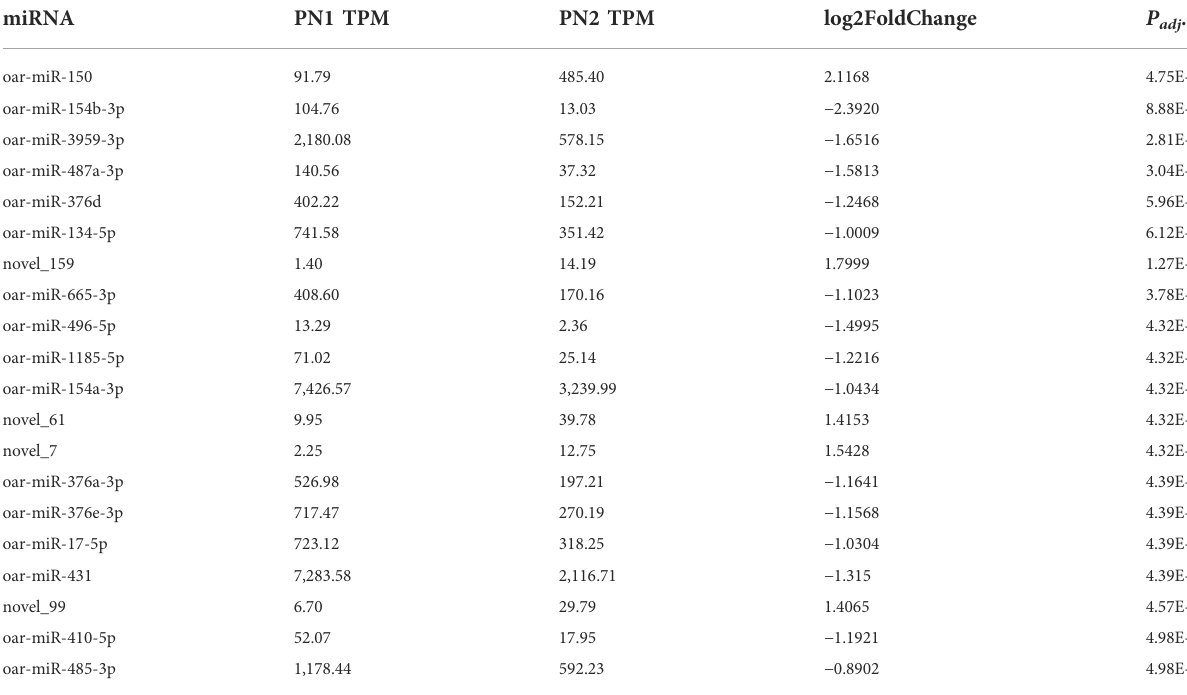
TABLE 2 Differentially expressed miRNA during mid prenatal phase (PN1 = gd85; PN2 = gd110) by signi fi cance level.